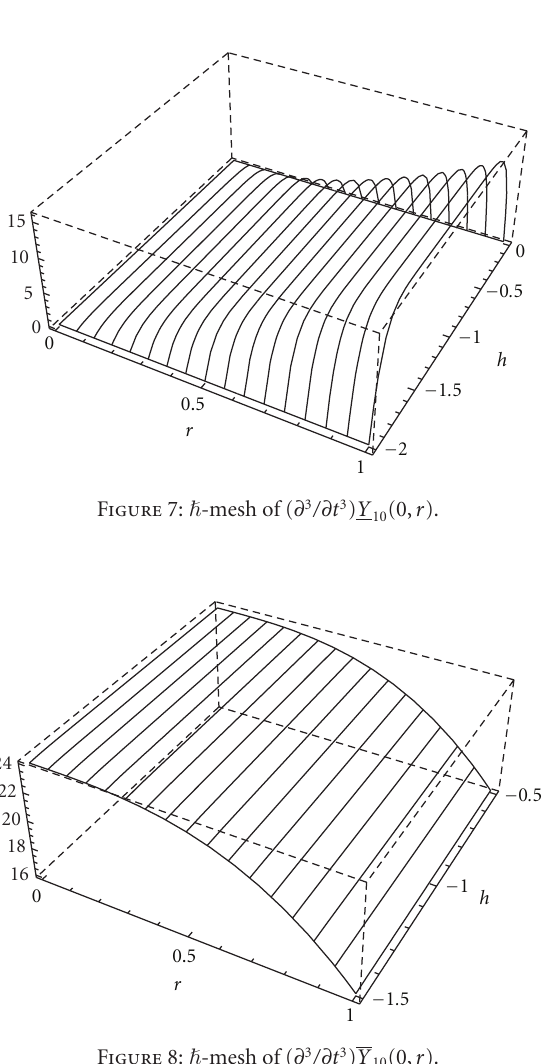
Figure 8: (cid:2) -mesh of ( ∂ 3 /∂t 3 ) Y 10 (0, r